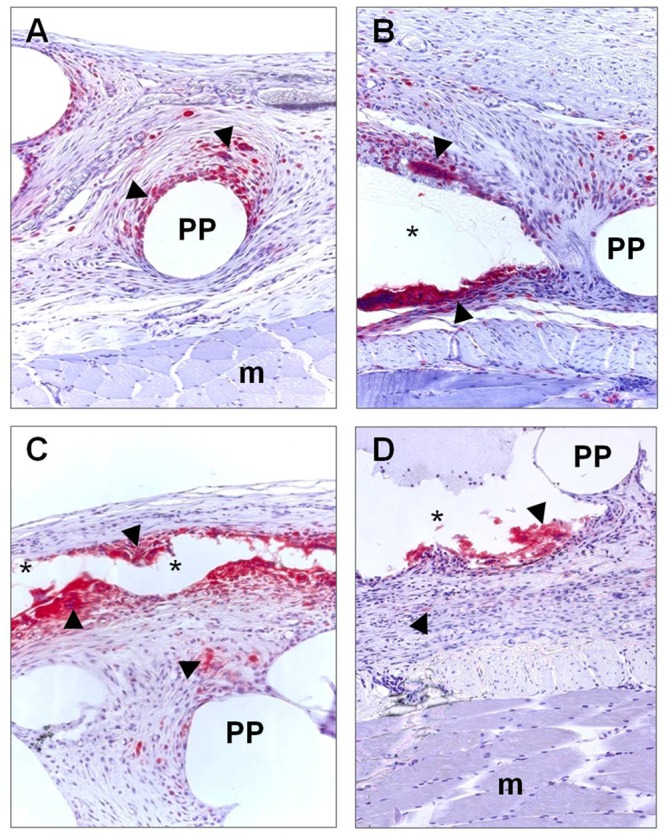
Macrophage response.Immunohistochemical labeling of rabbit macrophages (►) using RAM-11 monoclonal antibody in abdominal wall implanted with reticular PP mesh (Surgipro) fixed with sutures (control group) and with the different CAs (Glubran, Ifabond and OCA) 14 days after implantation. (A) Sutures, control group (200x). (B) Glubran (200x). (C) Ifabond (200x). (D) OCA. (200x). (*: Tissue Adhesive; PP: polypropylene filaments; m: muscle).